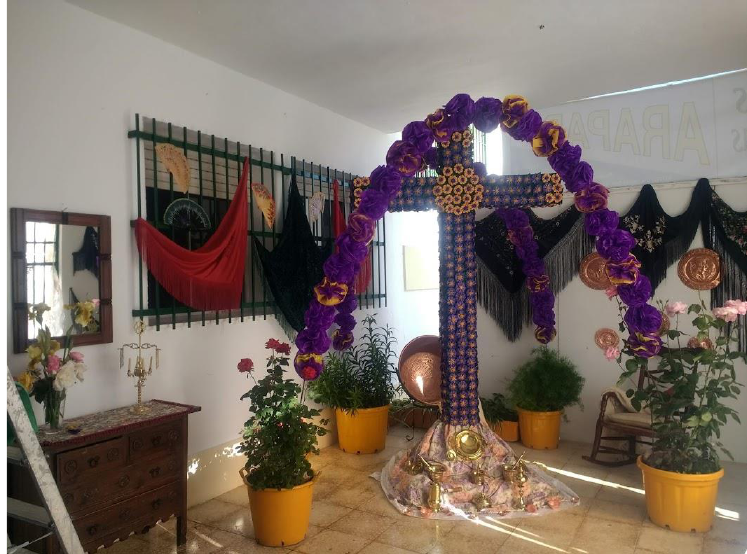
Photograph 13: The day centre’s decorated cross on display with local artifacts during Fiesta de las Cruces. Photograph taken by author. May,